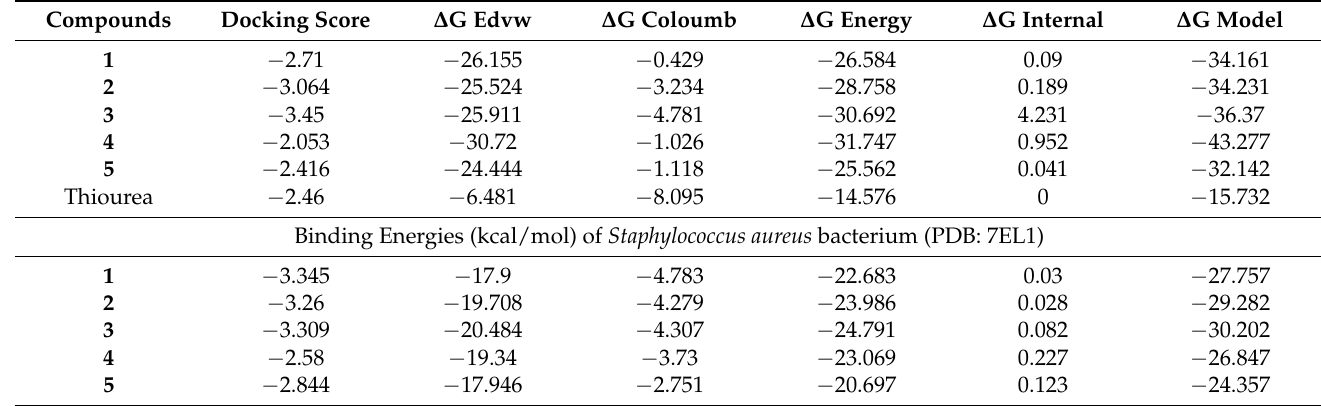
Table 7. Binding energies (kcal/mol) of urease (PDB: 2KAU) with selected ligands 1 to 5 . Compounds